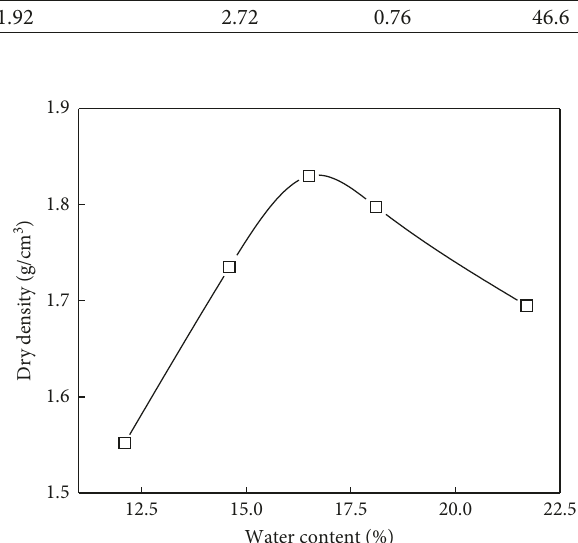
Figure 3: Particle-size distribution of the tested